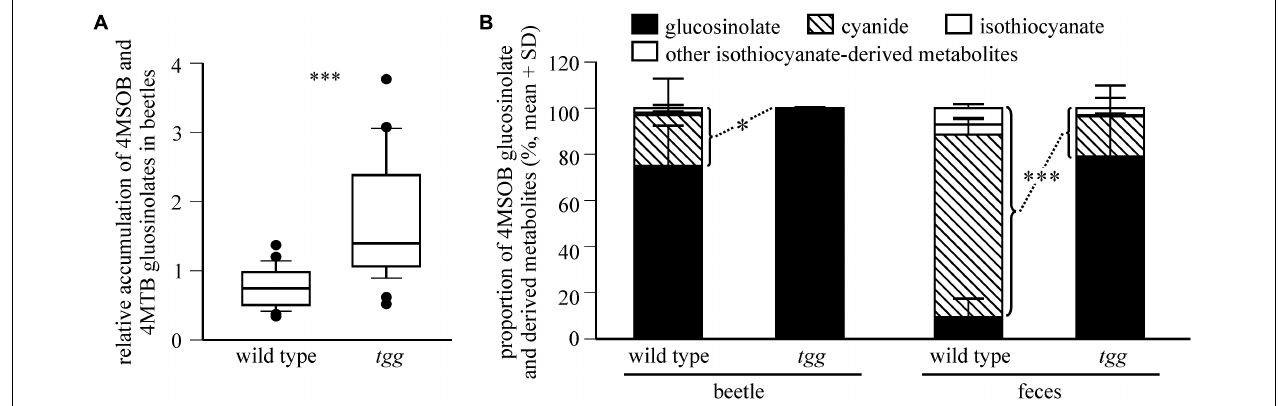
FIGURE 2 | Plant myrosinase activity influences glucosinolate sequestration in P. armoraciae . (A) Accumulation of 4-methylsulfinylbutyl (4MSOB) and 4-methylthiobutyl (4MTB) glucosinolates in P. armoraciae adults after feeding on Arabidopsis wild type and myrosinase-deficient tgg leaves ( n = 28 per plant genotype). Glucosinolates in beetles and fed leaves were extracted, converted to desulfo-glucosinolates and analyzed by high performance liquid chromatography coupled to diode array detection (HPLC-DAD). The glucosinolate concentration per mg beetle fresh weight is expressed relative to the concentration per mg plant fresh weight in the corresponding fed leaf, which was set to 1. Boxplots show the median and the 25 th and 75 th percentile. Dots represent data points that lie outside the 10 th and 90 th percentiles. Data were compared by Mann-Whitney rank sum test ( ∗∗∗ p < 0.001) (B) Relative composition of 4MSOB glucosinolate and hydrolysis products detected in bodies and feces of wild type- or tgg -fed adults ( n = 5 per plant genotype). Beetles that had fed on the Arabidopsis myb mutant served as a control ( n = 5). Glucosinolates and hydrolysis products were extracted with 50% methanol and analyzed by liquid chromatography coupled with tandem mass spectrometry (LC-MS/MS). Metabolites were quantified using external standard curves. The average amounts of each metabolite detected in control beetles and their feces was subtracted from the corresponding samples of wild type and tgg -fed beetles. The proportions of hydrolysis products relative to the total amount of detected glucosinolate and hydrolysis products in bodies and feces of wild type and tgg -fed beetles (set to 100%, respectively) were compared by Student’s t -tests (beetles: ∗ p = 0.025, feces ∗∗∗ p < 0.001). Results of statistical analyses are shown in Supplementary Table 1 . 4MSOB cyanide corresponds to the nitrile hydrolysis product of 4MSOB glucosinolate. Other isothiocyanate-derived metabolites comprise 4MSOB isothiocyanate-glutathione conjugate, 4MSOB isothiocyanate-cysteinylglycine conjugate, 4MSOB isothiocyanate-cysteine conjugate, 2-(4-(methylsulfinyl)butylamino)-4,5-dihydrothiazole-carboxylic acid, 4MSOB amine, and 4MSOB acetamide.